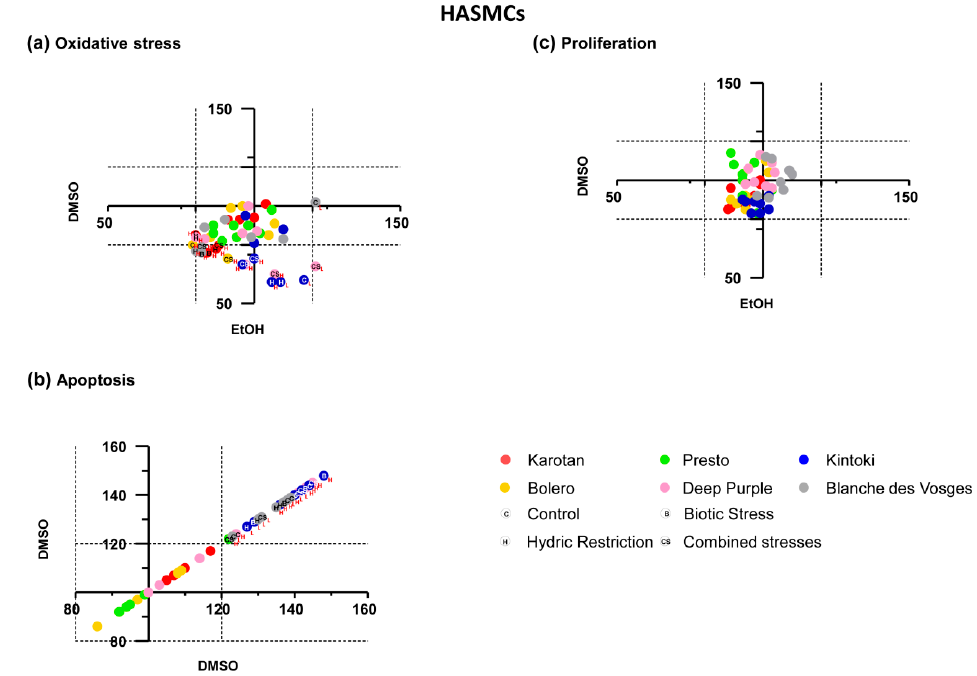
Figure A2. Effect of carrot extracts on smooth muscle cells. Oxidative stress ( a ), apoptosis ( b ) and Figure A2. proliferation ( c ) in HASMCs after treatment with carrot extract from different carrot varieties and